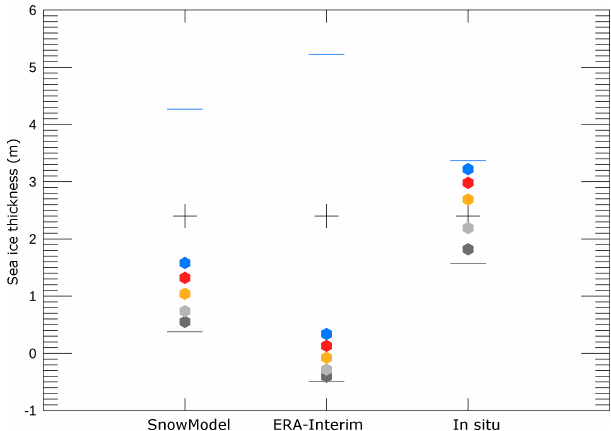
Figure 6. The range in CS-2-derived sea ice thickness in Novem- ber using snow inputs from SnowModel and ERA-I compared to snow input from in situ interpolated snow depths. Thickness de- rived from Eqs. (1) and (2) are shown with the grey and blue lines respectively and for Eq. (3) the dots are colour coded for different penetration depths ( P d ): dark grey is 0.02m, light grey is 0.05m, orange is 0.10m, red is 0.15m and blue is 0.20m. Black plus signs show in situ “mass-equivalent thickness”. This comparison is pro- duced from all CS-2 data height retrievals available over the in situ measurement area in November ( n =